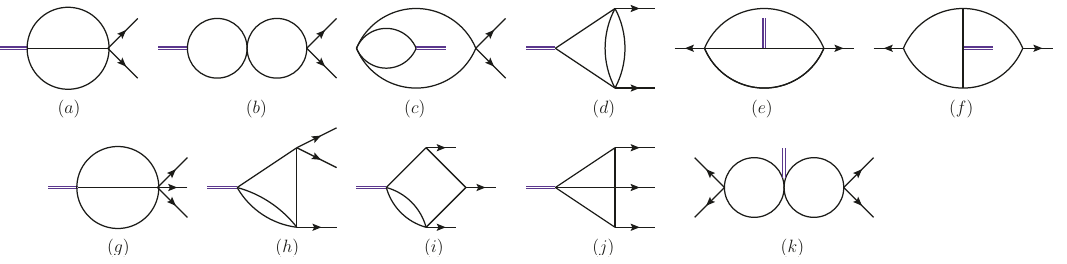
Figure 3 . The two-loop masters. The flipped versions of ( h ) and ( i ) are also included, which we do not draw.